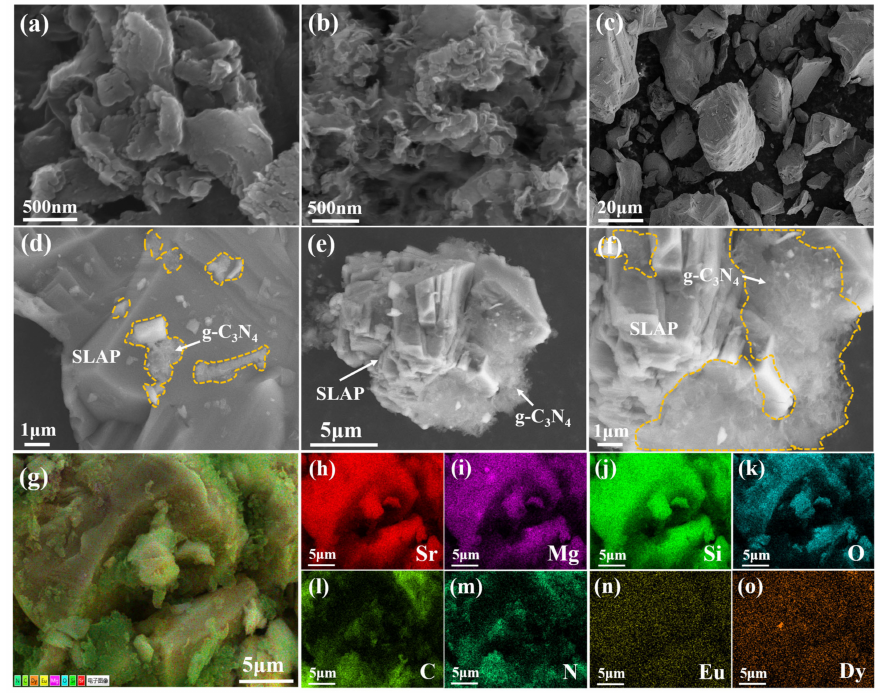
Figure 3. ( a ) SEM image of pristine g-C 3 N 4 ; ( b ) SEM image of g-C 3 N 4 after liquid phase exfoliation; ( c ) SEM image of SLAP; ( d ) SEM image of SLAP@CN-2.5; ( e – o ) SEM images of SLAP@CN-6 and their corresponding EDS element distributions.